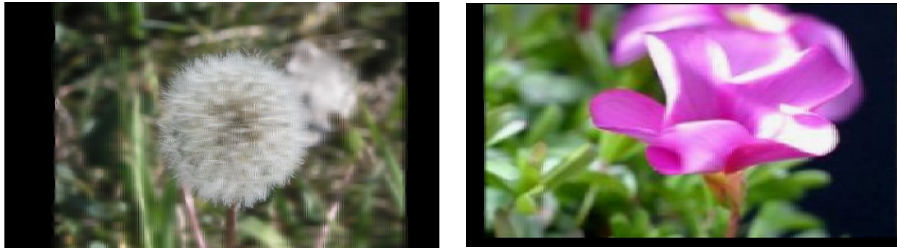
Figure 12. Three-dimensional image files with 40 LPI ( left ) and 70 LPI ( right ) lenticular screens.